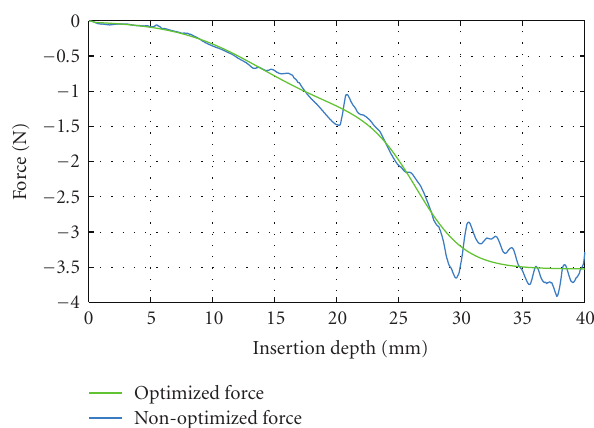
Figure 8: Optimized (green) and nonoptimized (blue) insertion forces measured by force sensor installed in the robotic system.